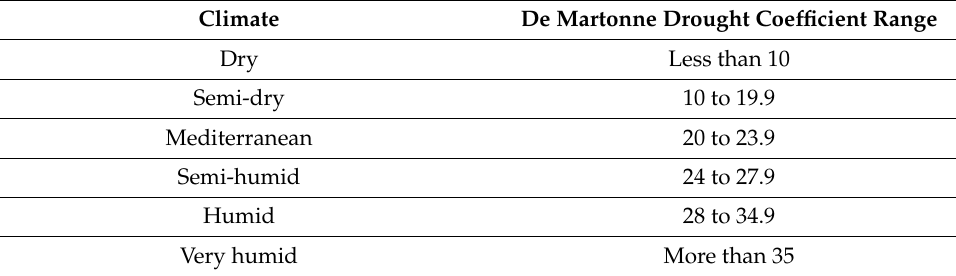
Table 2. Climatic classification for Iran based on the De Martonne